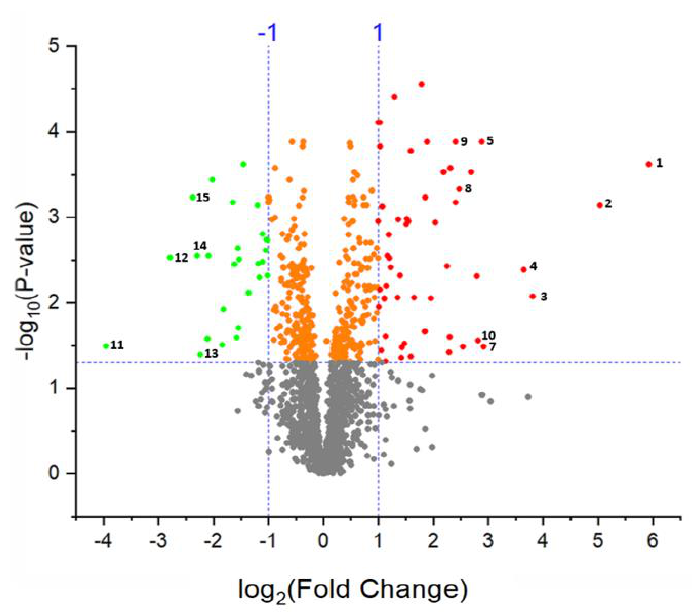
Figure 7. Volcano plot of differentially abundant proteins in the guard cells in response to salt stress.